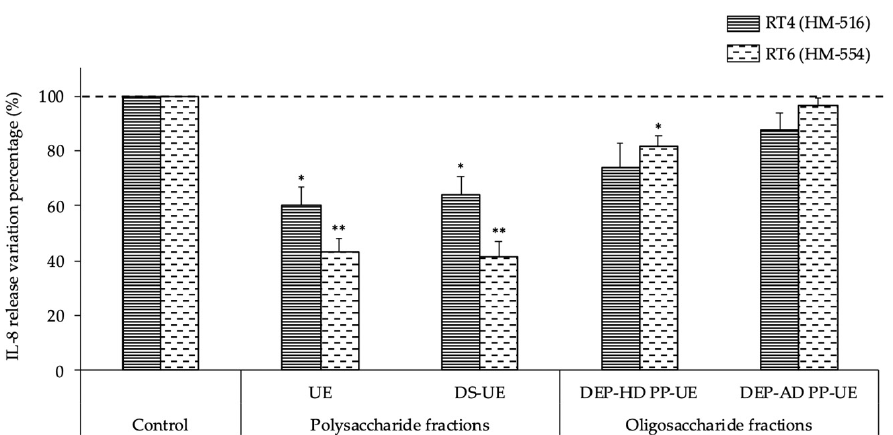
Figure 8. Effects of poly- and oligosaccharide Ulva sp. fractions at 1000 µ g/mL on the inflammatory potential of C. acnes RT4 ( n = 3) and C. acnes RT6 ( n = 3) towards HaCaT keratinocytes evaluated by IL-8 ELISA assay. Significant differences between the control (bacteria preliminarily cultured in medium alone) and after the bacteria were preliminarily cultured with fractions are indicated by * p < 0.05 and ** p <